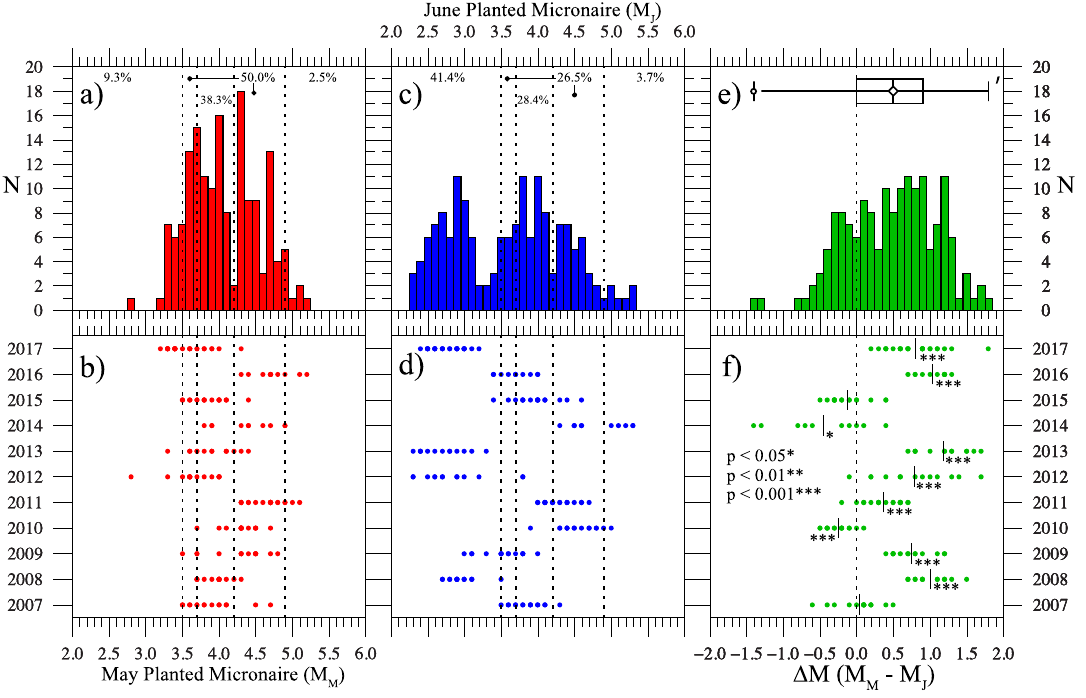
Figure 5. ( a ) Count histogram of May-planted micronaire values from the AgriLife irrigated variety trials. ( b ) May-planted micronaire by year. ( c ) As in ( a ) for June-planted micronaire. ( d ) As in ( c ) for June-planted micronaire. ( e ) Count histogram of May-planted minus June-planted micronaire effects (ΔM) calculated from the same cultivar planted on May and June planting dates during each year. Bar plot marks the distribution’s minimum and maximum, and 25th, 50th and 75th percentiles. ( f ) Micronaire effects plotted by year. Vertical lines mark sample means. Stars show mean effects significant at at least a 95% confidence level ( p < 0.05) as determined by a one sample t-test.